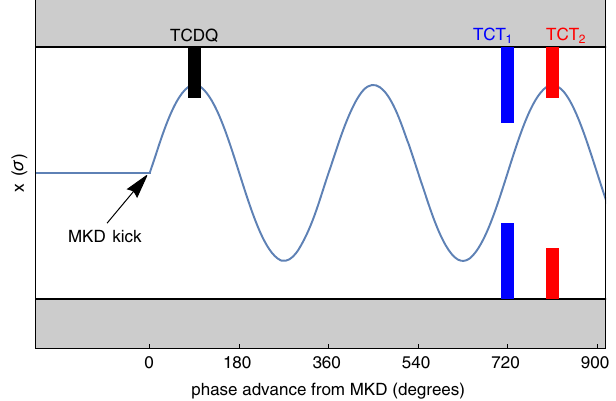
FIG. 2. Principle of avoiding damage on the TCTs and the nearby low-beta quadrupoles by constraining the phase advance between MKD and TCT close to 0°: If the TCT would be at 90° phase advance, the remaining particles would fully hit the TCTs (case of TCT 2 , red). In case of 0° (TCT 1 , blue), the beam just passes through the TCTs and no damage occurs. Courtesy of R. Bruce